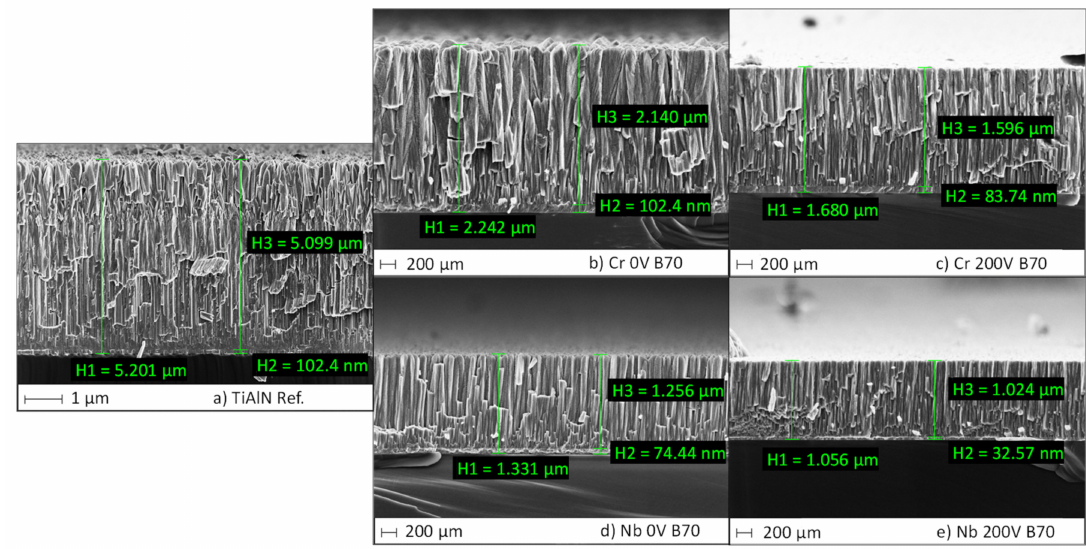
Figure 4. SEM cross sections of the reference TiAlN sample ( left , ( a )) prepared with a straight DC bias of − 70 V, and (TiAl) 1 − x (Cr,Nb) x N films deposited with no positive accelerating voltage ( middle , ( b , d )) and +200 V accelerating voltage ( right , ( c , e )).